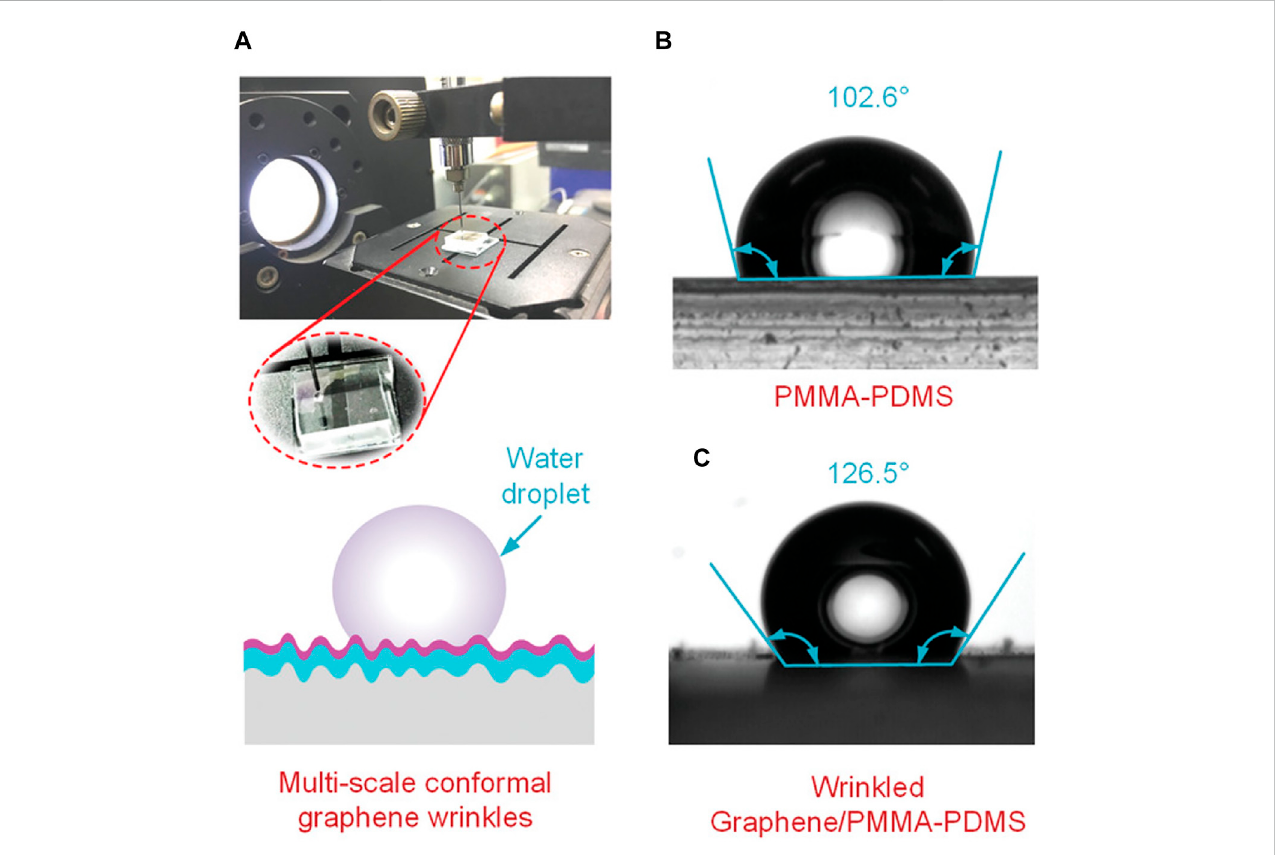
FIGURE 7 (A) Testing platform and schematic. (B) and (C) The material and the wrinkling pro fi le of supporting surface affect the contact angle. Reprinted with permission from (Hu et al., 2020). Copyright (2020) by the John Wiley &